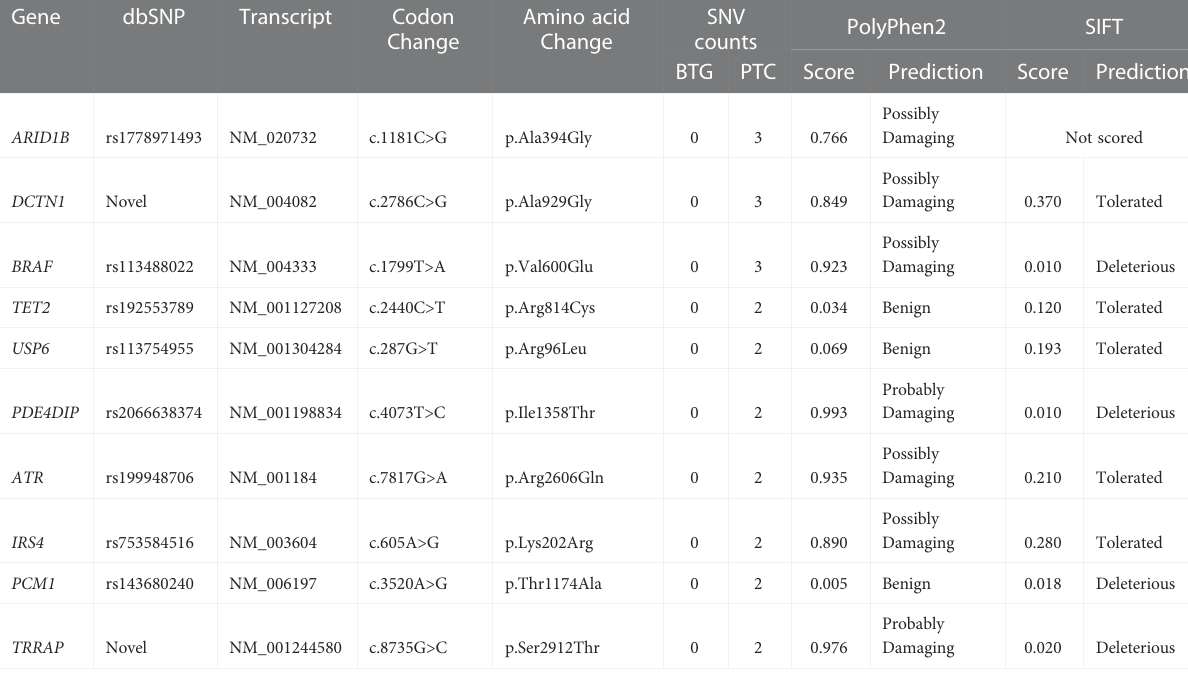
TABLE 1 Ten PTC-speci fi c SNVs and their in silico functional impact predictions.